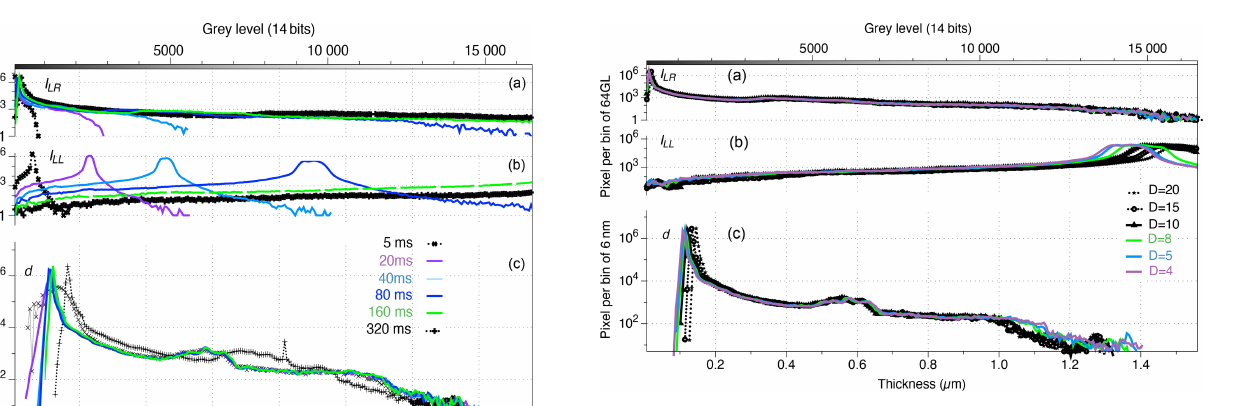
Figure 4. Histograms (bins of 64 grey levels (top) and 6nm (bot- tom)) of the same field of view as in Fig. 2, captured with green monochromatic light λ = 561nm in right circular polarization (a) , left circular polarization (b) and the resulting thickness using Eq. (2) (c) at different openings (Leica DM6000B scale ranging from 1 (closed) to 20 (open)) of the field diaphragm (black with stars: 20; black with circles: 15; black with squares: 10; green: 8; blue: 5; and purple: